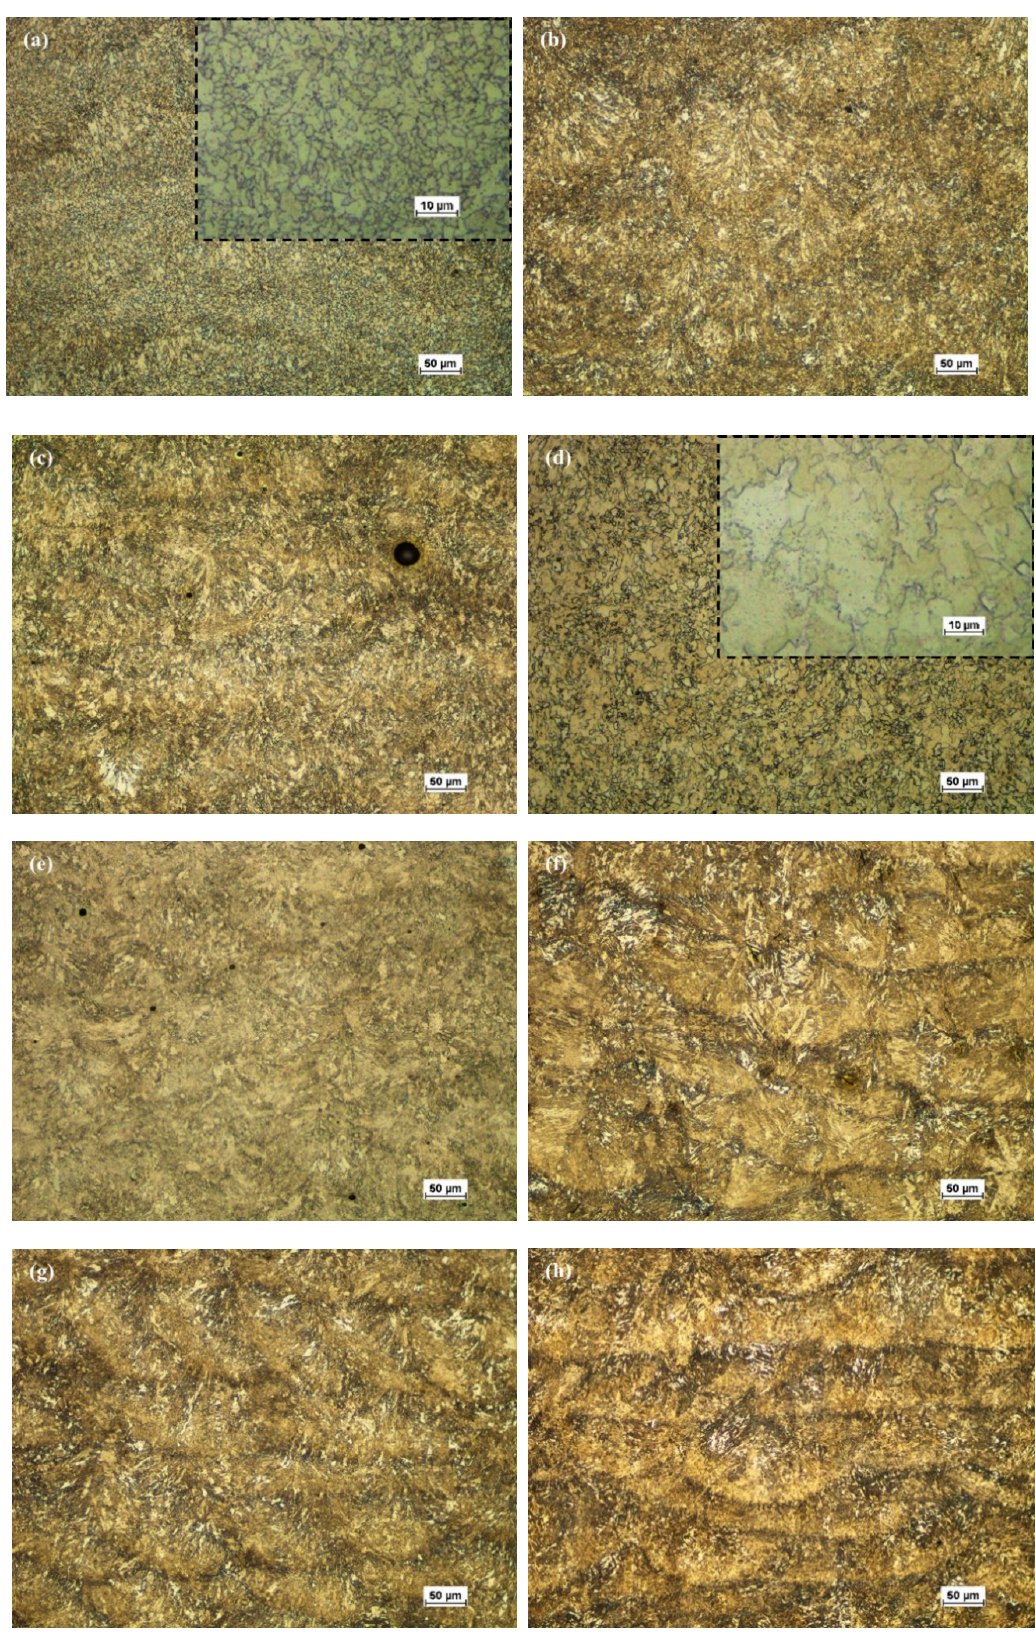
Figure 5. Optical micrographs of ( a ) W-1, ( b ) W-2, ( c ) W-3, ( d ) W-4, ( e ) WT-1, ( f ) WT-2, ( g ) G-1 and ( h ) G-2 alloys processed by L-PBF.